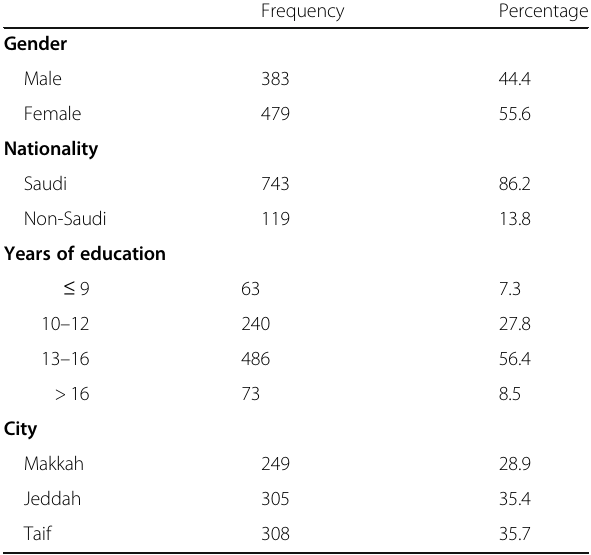
Table 1 Personal characteristics of the participants ( n = 862)